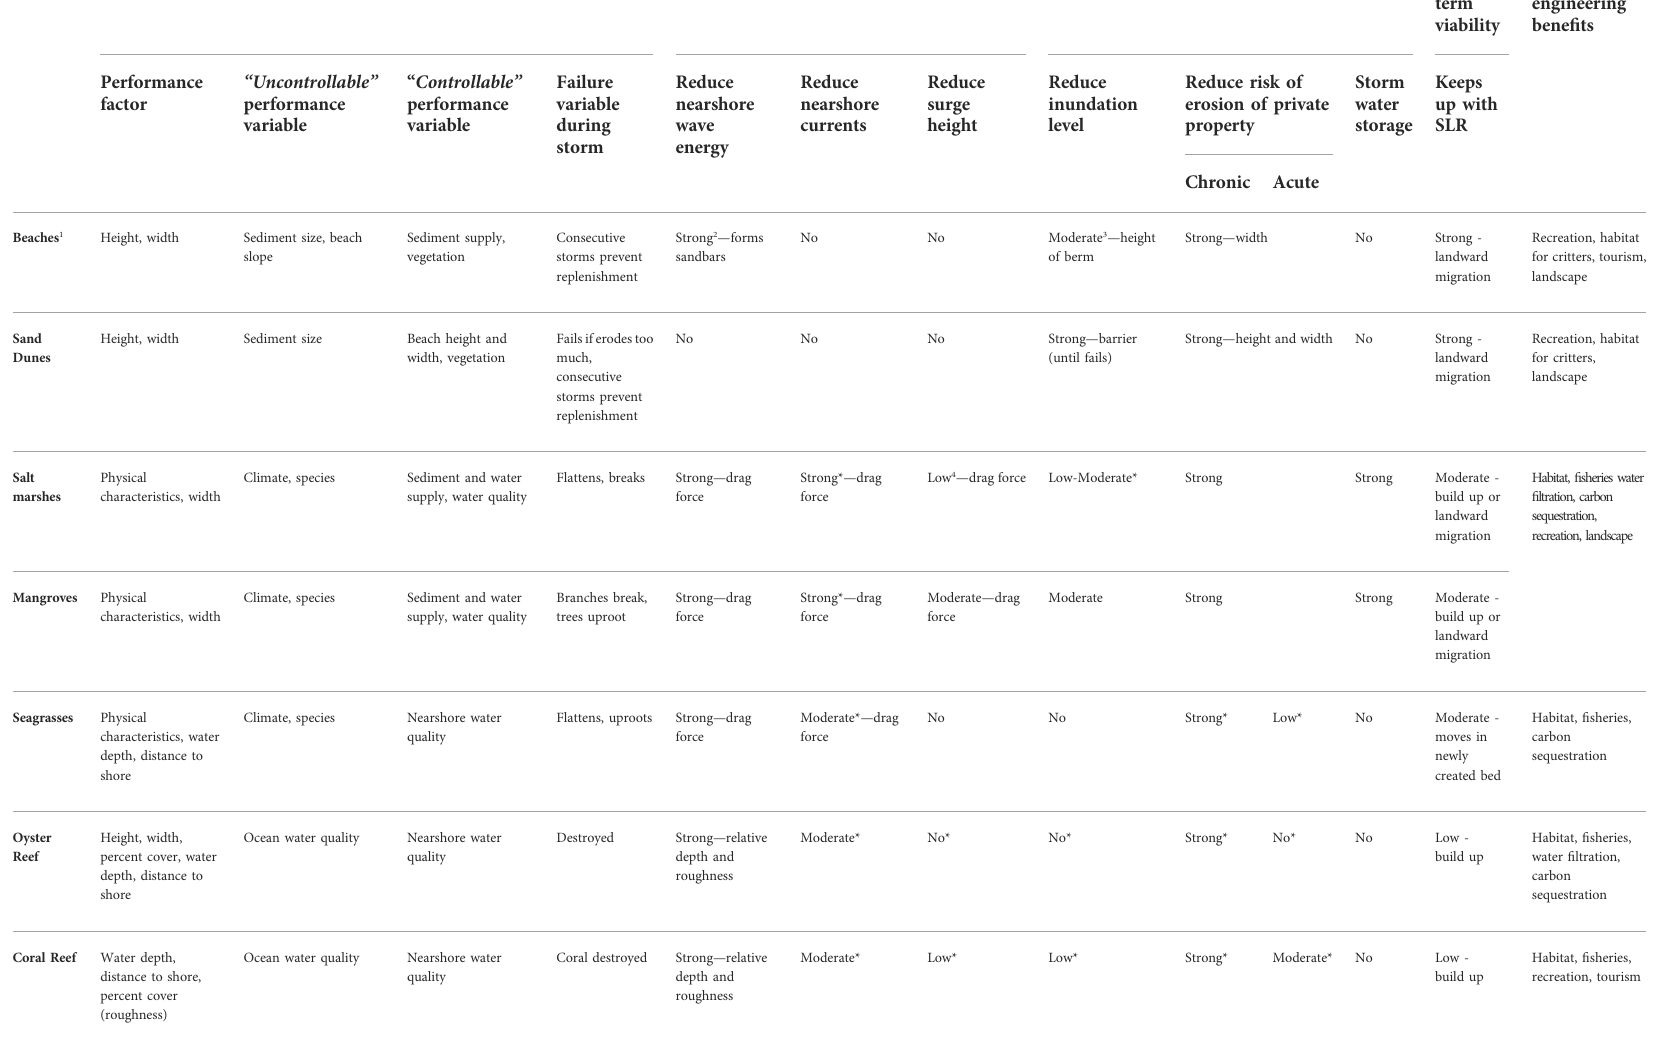
TABLE 1 Protection provided by common NNBF